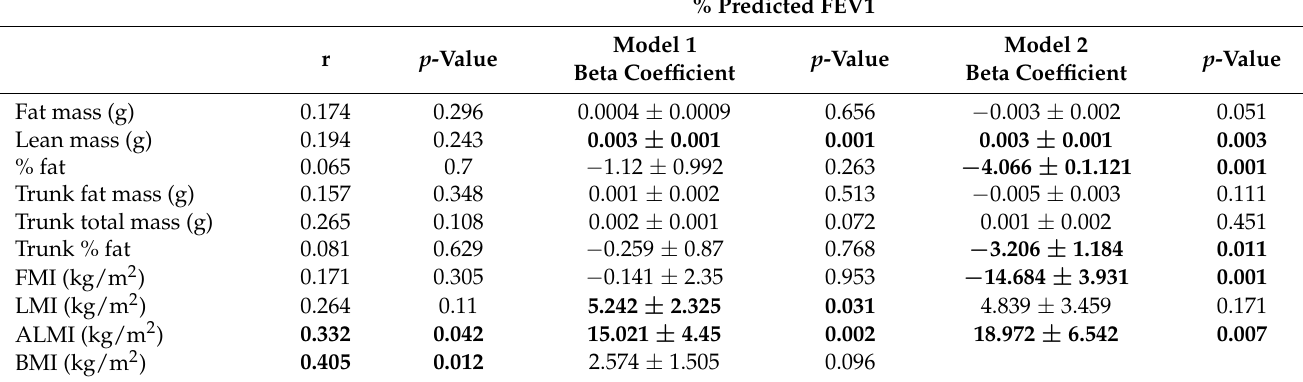
Table 3. Correlation analyses and multiple linear regression of FEV1 vs. body composition measures in participants with CF.